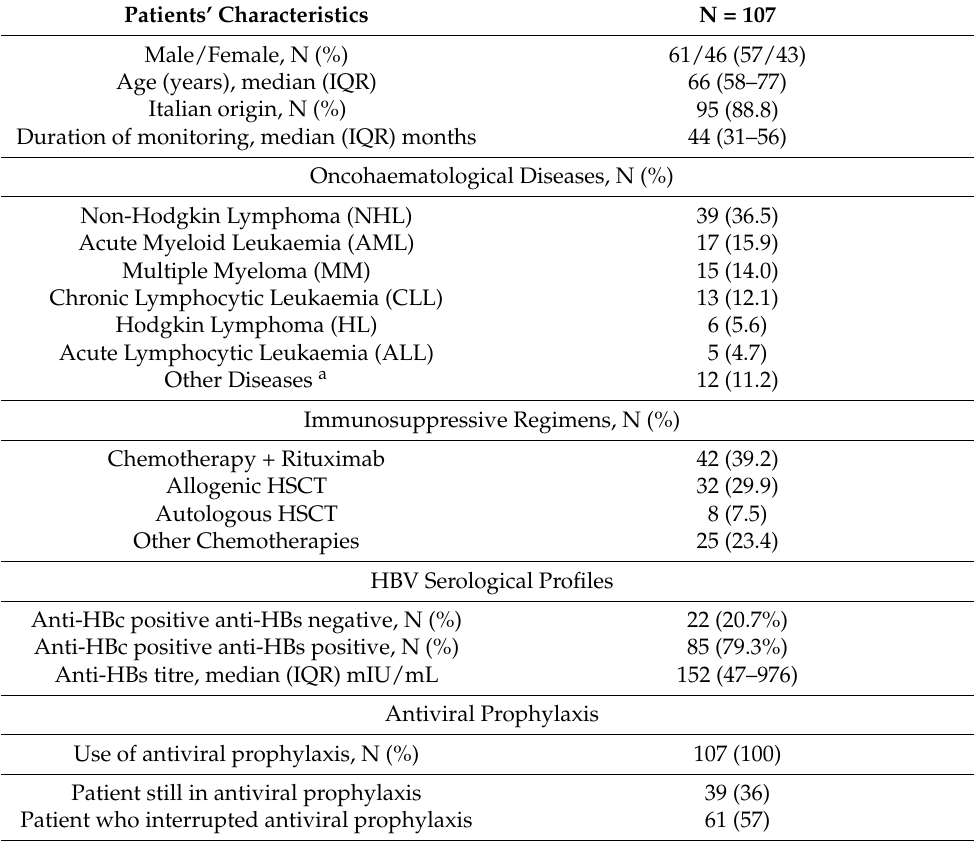
Table 1. Characteristics of the study